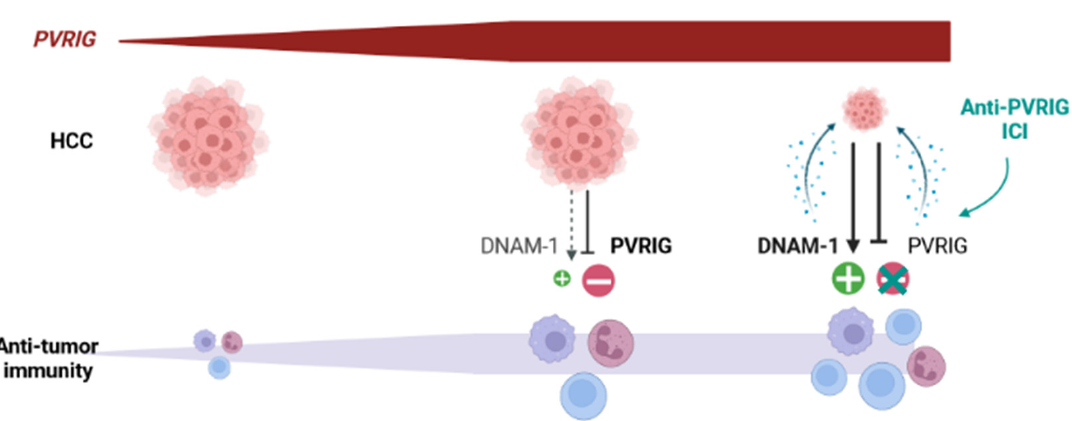
Figure 7. Hypothetical evolution of HCC after treatment with an anti-PVRIG in PVRIG High tumors: PVRIG High HCC are infiltrated with cytotoxic cells, whose activity is not fully unleashed. Our hypothesis is that anti-PVRIG treatment might alleviate this inhibitory signal (one among others) in innate and adaptive cytotoxic cells expressing PVRIG. This might favor anti-tumor activation and lead to better tumor regression and better clinical outcome.